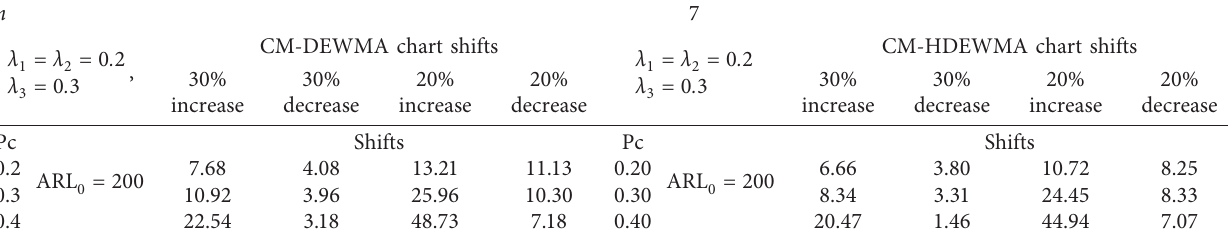
Table 9: Out-of-control ARL Values for CM-HDEWMA and CM-DEWMA control charts for n � 7 with α � 1 . 5 , β � 2 . n 7 � λ � 0 . 2 λ 1 2 � 0 . 3 λ 3